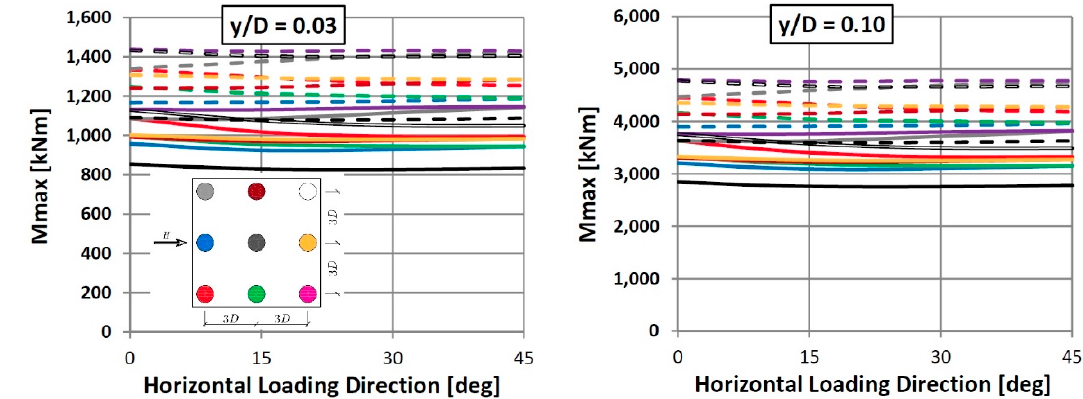
Figure 16. Maximum bending moments for square 3 × 3 pile group ( s x = 3 D , s y = 3 D ). Different colors denote piles inside the pile group. Full lines—loose sand; dashed lines—dense sand.